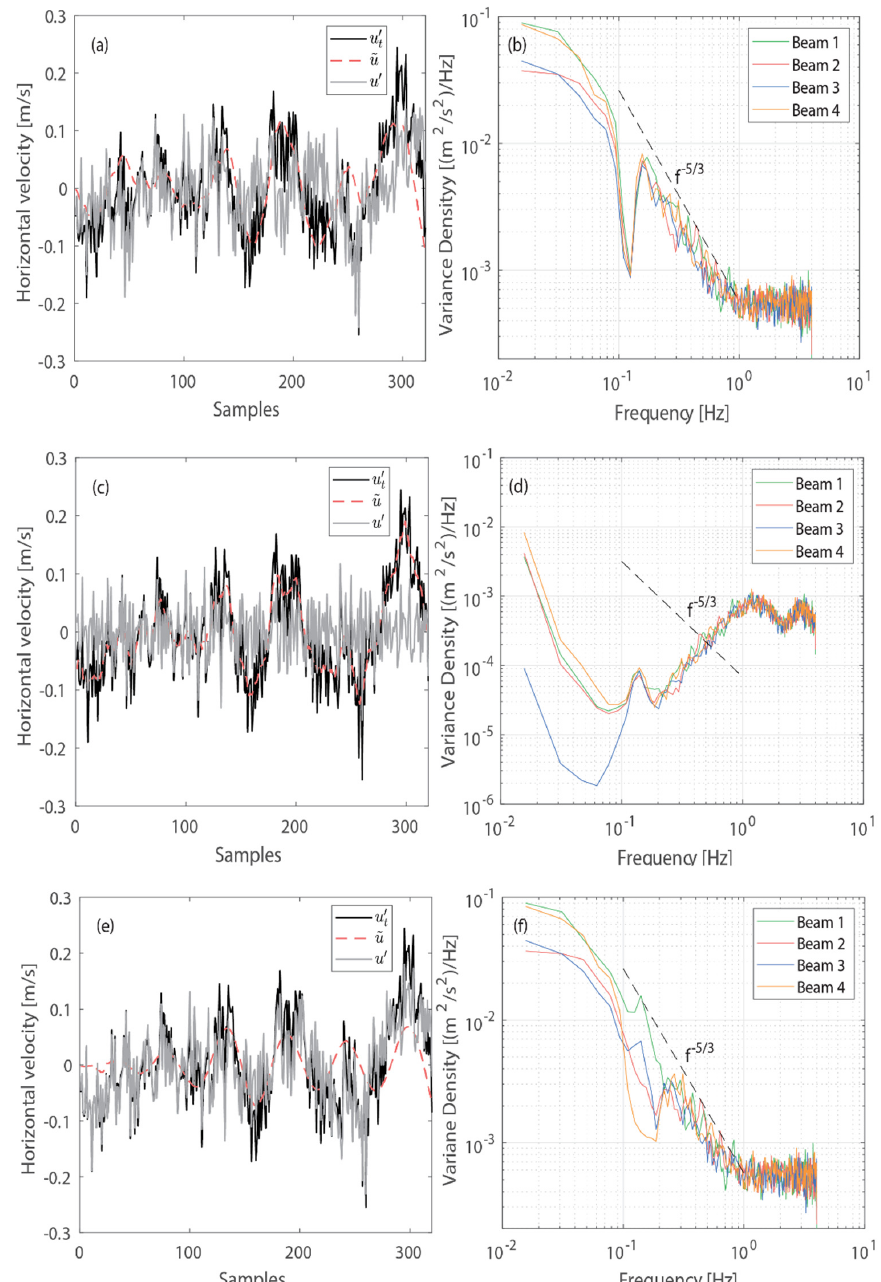
Figure 6. Original and decomposed velocity fluctuations time series from beam 2 and turbulent kinetic energy spectrum and after wave-turbulence decomposition performed in beam coordinates with ( a , b ) the stopband (SB) method, ( c , d ) moving average (MA) method, and ( e , f ) synchrosqueezing wavelet transform (SWT) method. Velocity time series obtained from beams 1, 3, and 4 presented similar results as beam 2. Mean streamwise velocity during this burst measurement was 1.26 m /